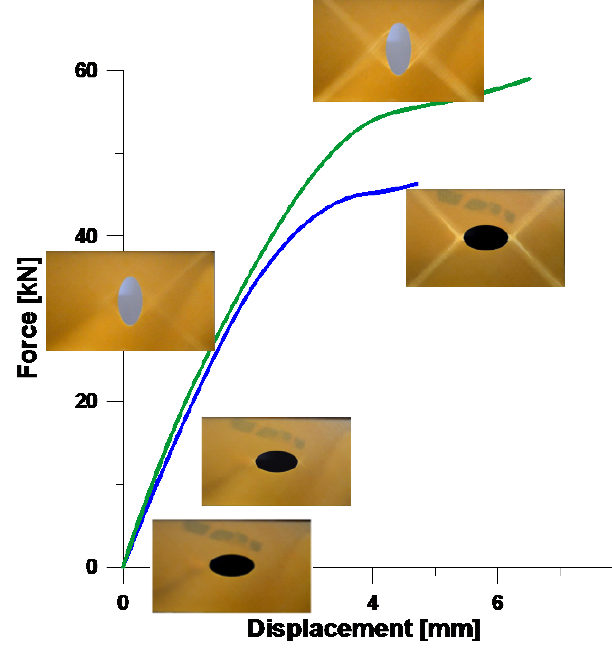
Figure 4. Static deformations of rectangular panels with elliptical holes.